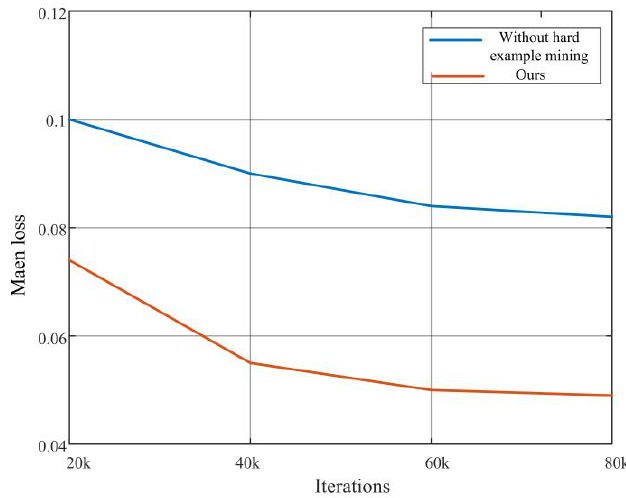
Figure 11. Comparison of the loss values. Table 7. Comparison of the results.